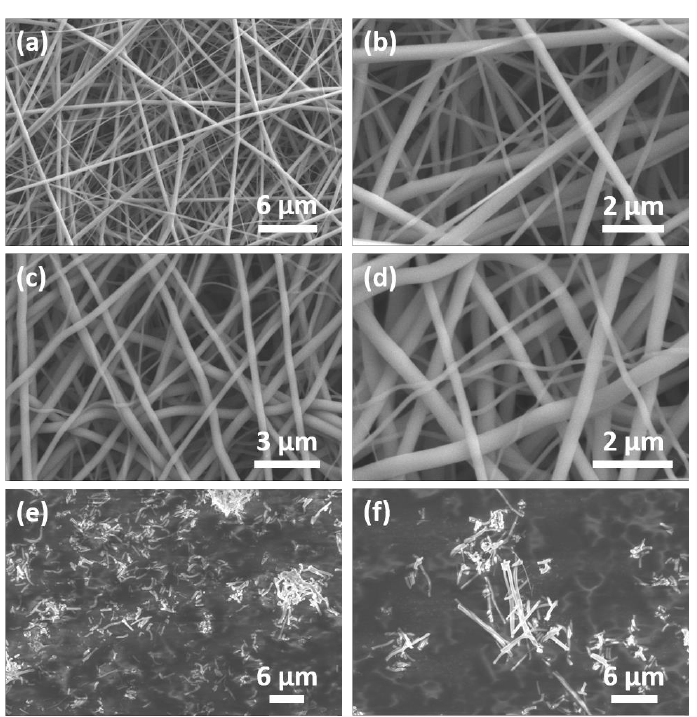
Figure 4. SEM images of the electrospun silica nanofibers. ( a , b ) polyvinylpyrrolidone